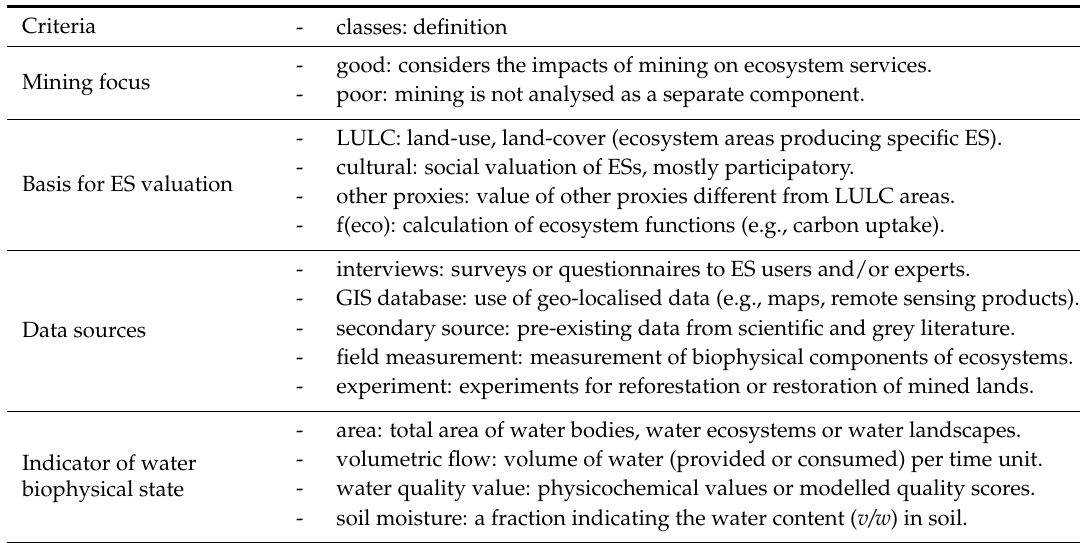
Table 1. Criteria for reviewing ecosystem services (ES) assessments applied to mining